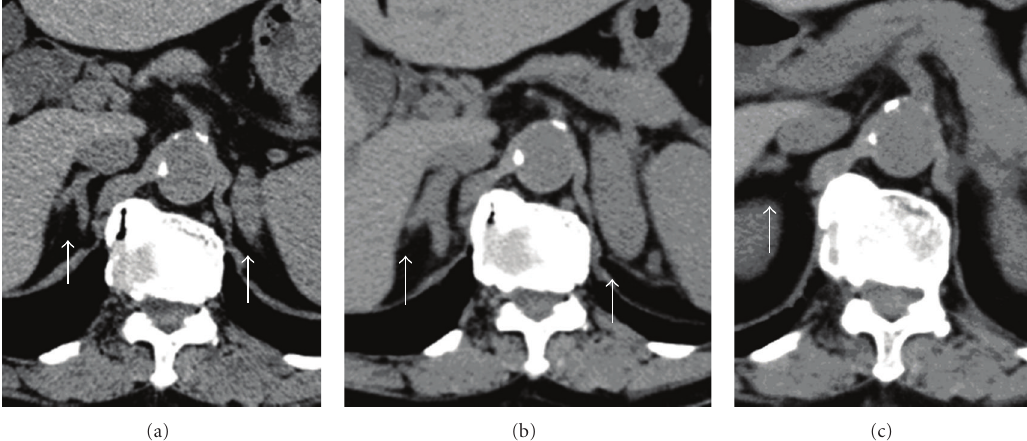
Figure 2: CT image (a) on the first visit; (b) 1 year after the first visit revealing enlarged adrenal glands; and (c) after R-CHOP therapy showing shrinkage of the right adrenal